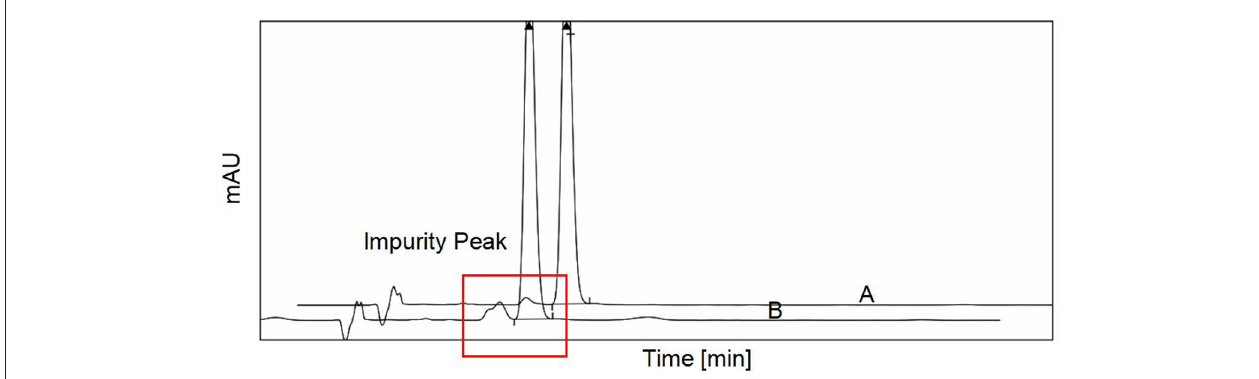
FIGURE 1 | The purity of two different diosmin preparations was detected by high-performance liquid chromatography (HPLC). The two different purity of diosmin we used in this study was presented. The impurity peak was demarcated by the red frame. A, diosmin A. B, diosmin